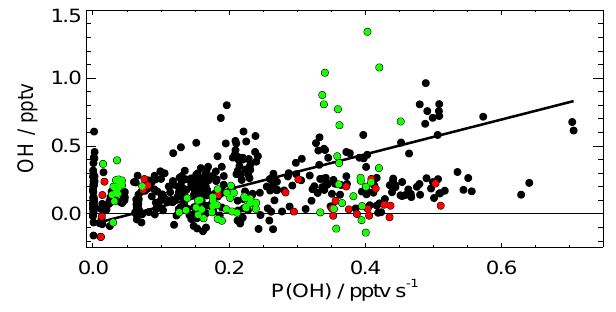
Fig. 13. Correlation between OH (pptv) and P (OH) (pptvs − 1 ): slope=1.28 ( ± 0.06)s; intercept= − 0.1 ( ± 0.01); R 2 =0.11. Green points indicate observations in the boundary layer with isoprene greater than 300pptv. Red points indicate observations within a biomass burning plume with acetonitrile higher than